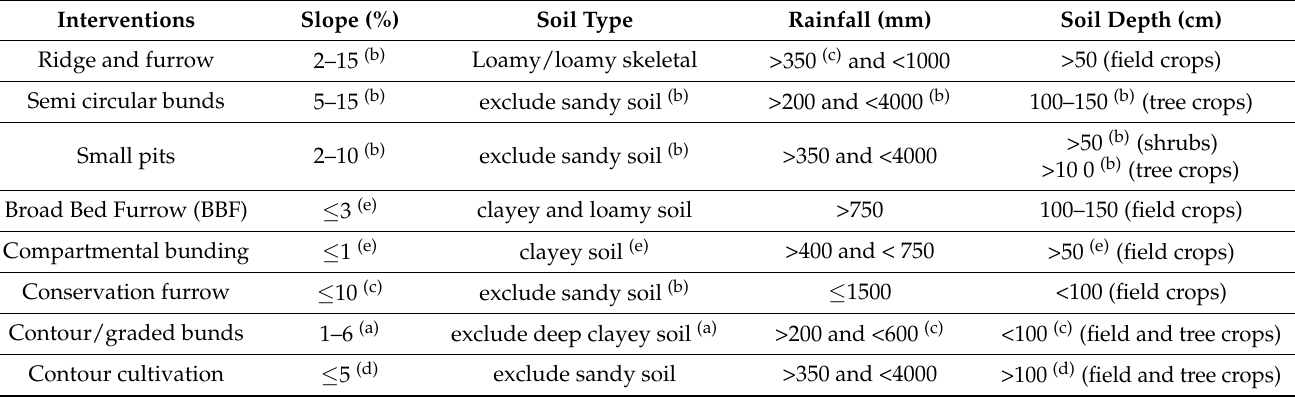
Table 1. Criteria for planning selected in situ soil and water conservation interventions.